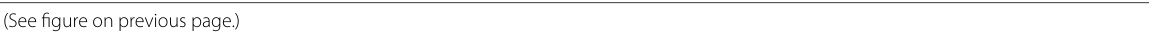
figure on previous Fig. 5 Enhanced heat tolerance of hmhsp70 overexpression transgenic tobaccos. a The survival numbers of heat-shocked WT and transgenic tobaccos after 7 days of recovery growth at 25 °C. The transgenic and WT tobaccos grew on normal temperature (25 °C) in tissue culture bottles were shifted to high temperature (46 °C, 48 °C, 50 °C, 52 °C) for 4 h. b The typical phenotype of heat-shocked WT and transgenic tobaccos after 7 days of recovery growth at 25 °C. The shock temperature was indicated in the photos. Each value is the mean from three parallel replicates Two-tailed t test, performed by SPSS 18.0 (Chicago, Illinois, USA), was used to calculate statistical significance. Different letters in the same group of bars indicate a significant difference (P <